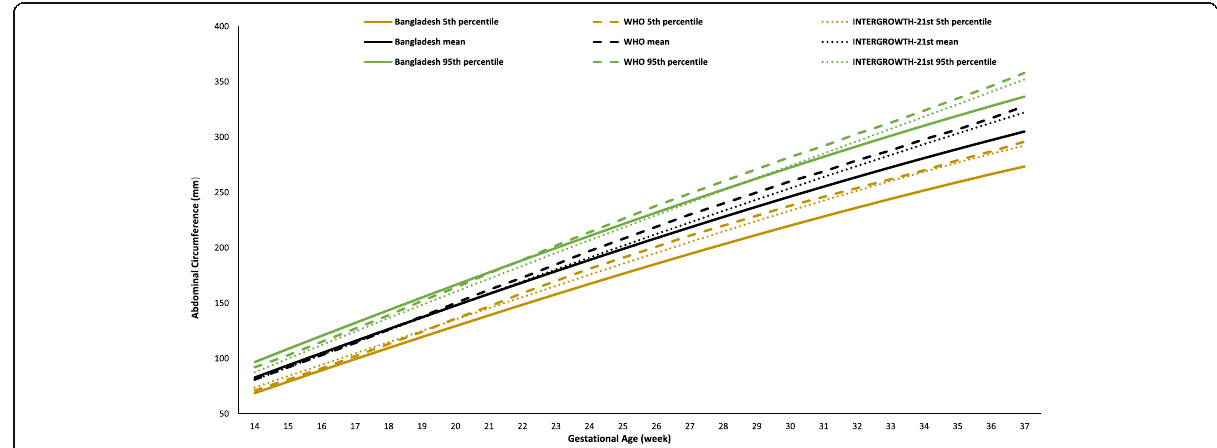
Fig. 4 Comparison of abdominal circumference (AC) with WHO [11] and INTERGROWTH-21st [16] values